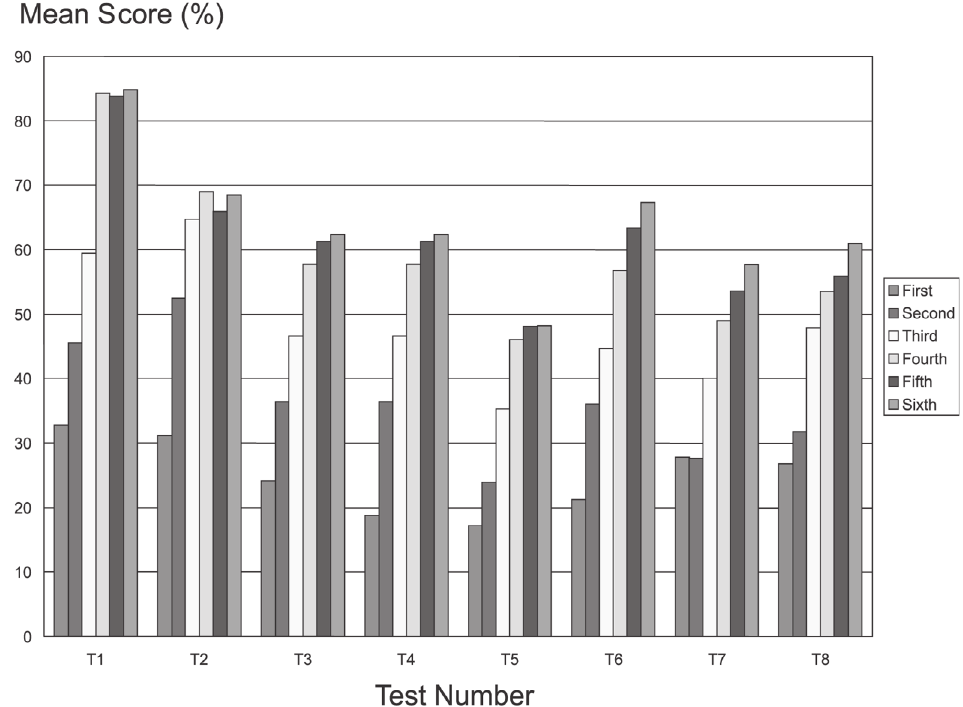
Figure 3 - Mean scores (%) for clinical science questions, for students from first to sixth year, according to occasion on which the test was applied (tests 1- 8). (test 1 to 8, P < .0001). *For each sequence of columns, the first represents first-year students; the second, second-year students; the third, third-year students; the fourth, fourth-year students; the fifth, fifth-year students; and the sixth, sixth-year